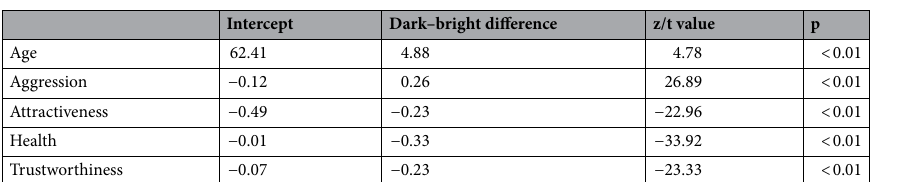
Table 2. Summary of the models for each of our dependent variables. The model for age is a linear regression with error structure. All other models are generalized linear models with error structure.